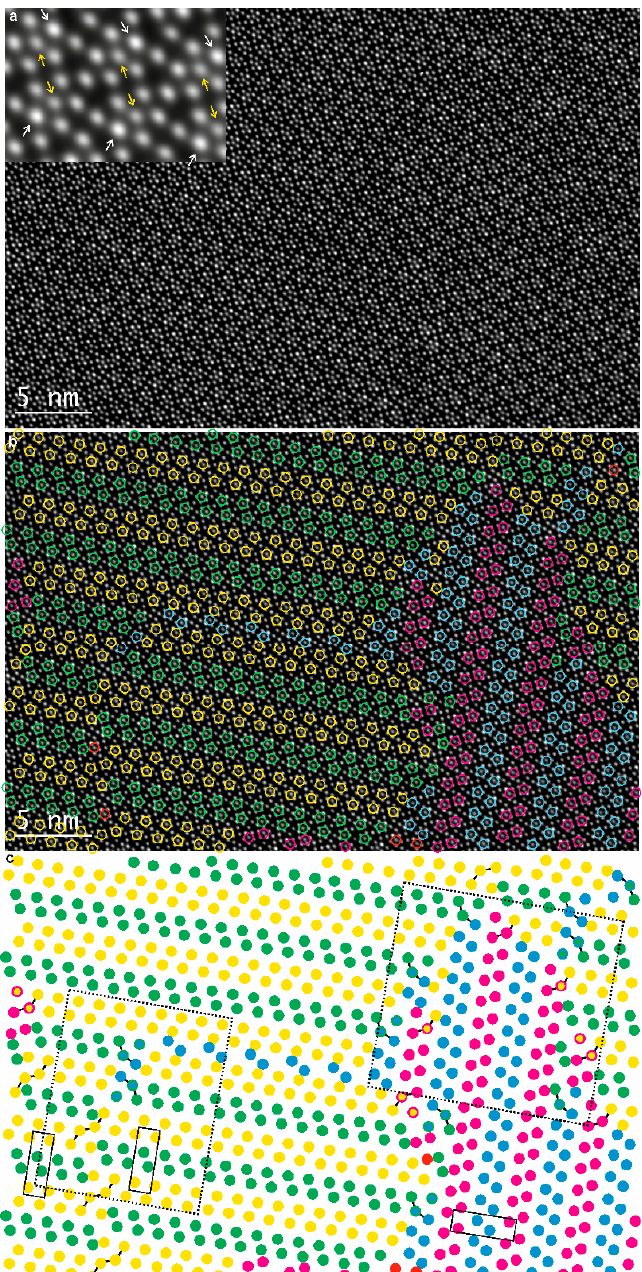
Figure 3. ( a ) HAADF-STEM image of Nb 18 W 16 O 93 recorded along [001] (courtesy of Prof. L. Shen, Nanjing) and ( b ) with the filled pentagonal tunnels (PTs) marked as open circles. ( c ) Scheme of the PT array. Rectangles framed by solid lines indicate unit cells of Nb 8 W 9 O 47 and those framed by dotted lines represent the areas interpreted in Figure 4. The magnified area (inset in ( a )) demonstrates the varying dot intensities with white arrows pointing to W-rich positions and yellow arrows to Nb-rich positions.